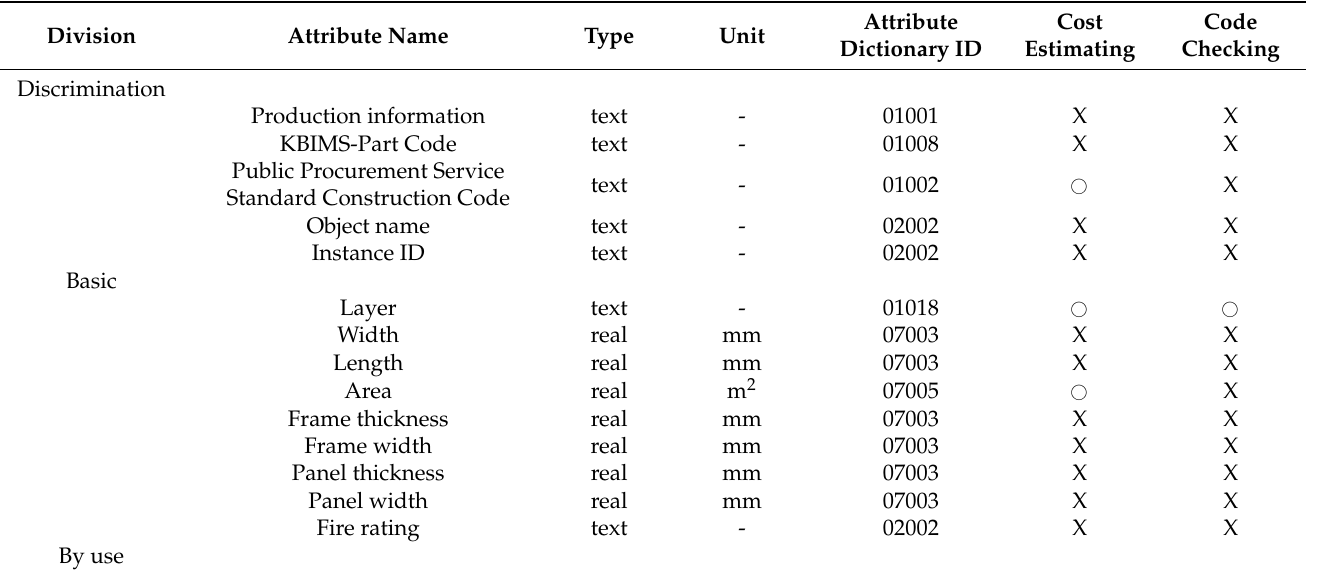
Table 9. Model Layer—Part of